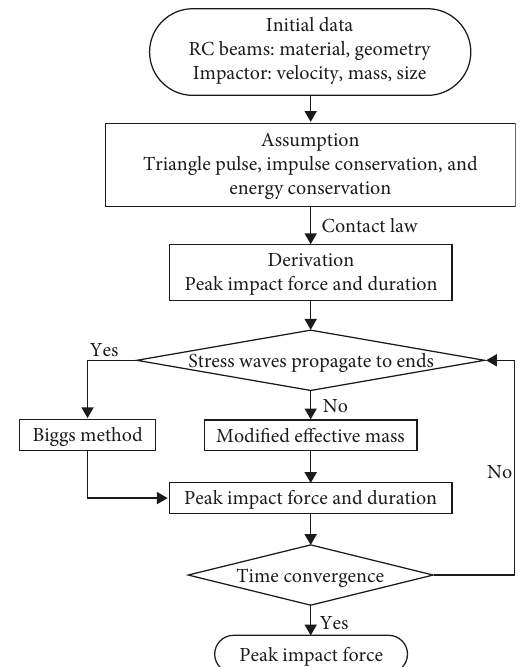
Figure 6: Flowchart for calculating the peak impact force.